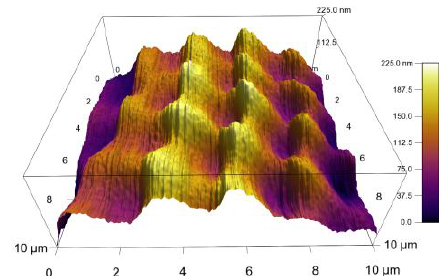
Figure 2: 10  m x 10  m section of articular cartilage surface illustrated by the insert in figure